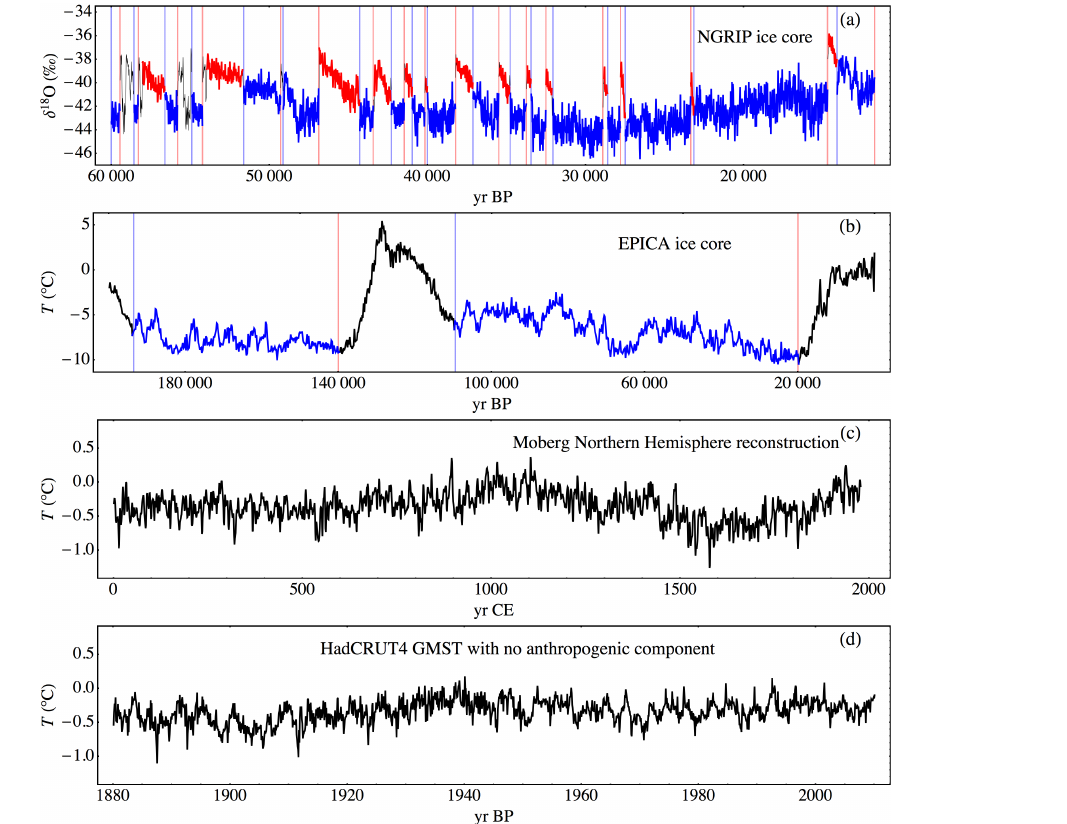
Figure 1. (a) The δ 18 O concentration in the NGRIP ice core dating back to 60kyr before present (BP). Here present means AD 2000 ( = 2000CE). The data are given as 20-year mean values. The time series are split into stadial (blue) and interstadial (red) periods. (b) The temperature reconstruction from the EPICA ice core. The shown time series are sampled with a time resolution of roughly 200 years. The temperature curve in the glacial periods is given in a blue colour. (c) The Moberg reconstruction for the mean surface temperature in the Northern Hemisphere. The data are given with annual resolution. (d) The HadCRUT4 monthly global mean surface temperature where the anthropogenic component has been removed using a linear-response